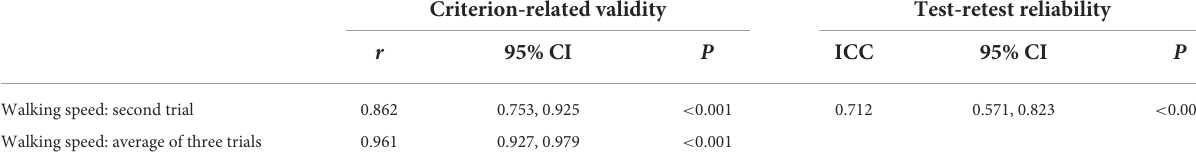
TABLE 2 Validity and reliability of the 10-meter walk test by study participants and professional